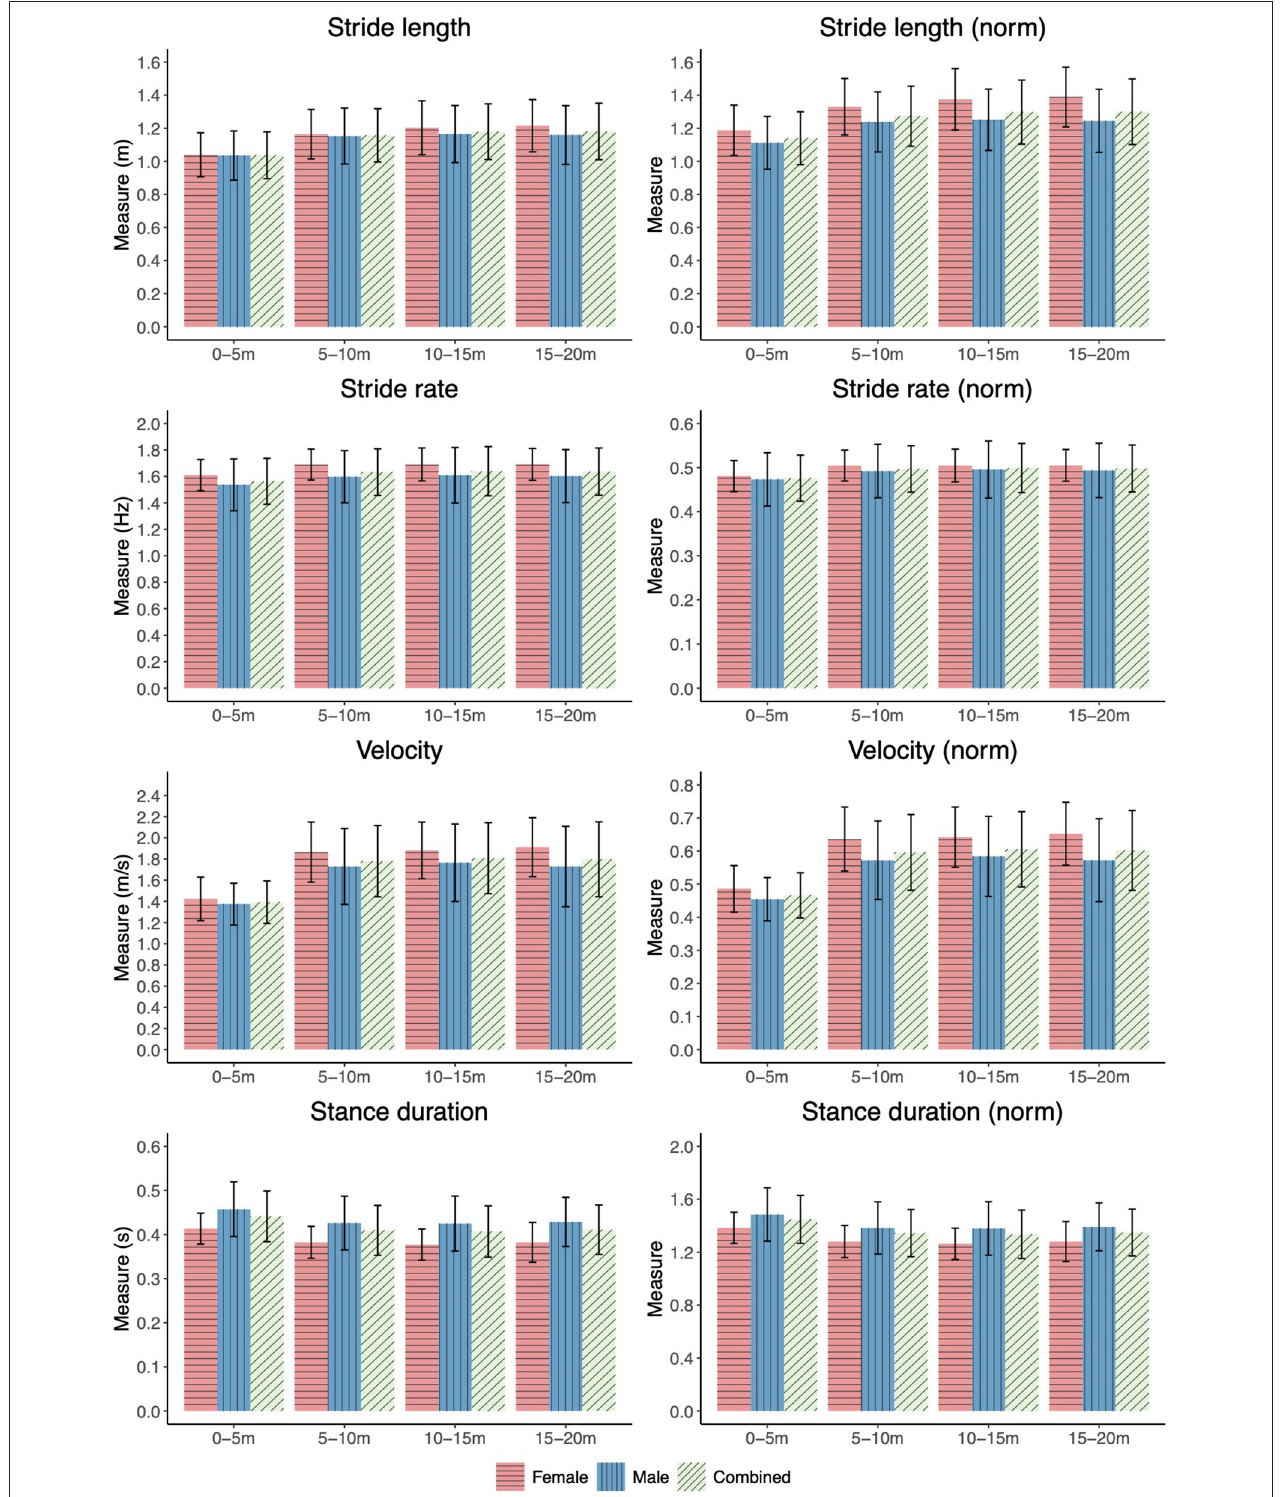
FIGURE 6 | Spatiotemporal measures for each 5m interval of the 20m yoke walk.